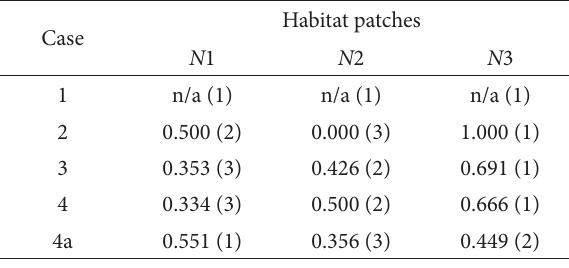
Habitat patches